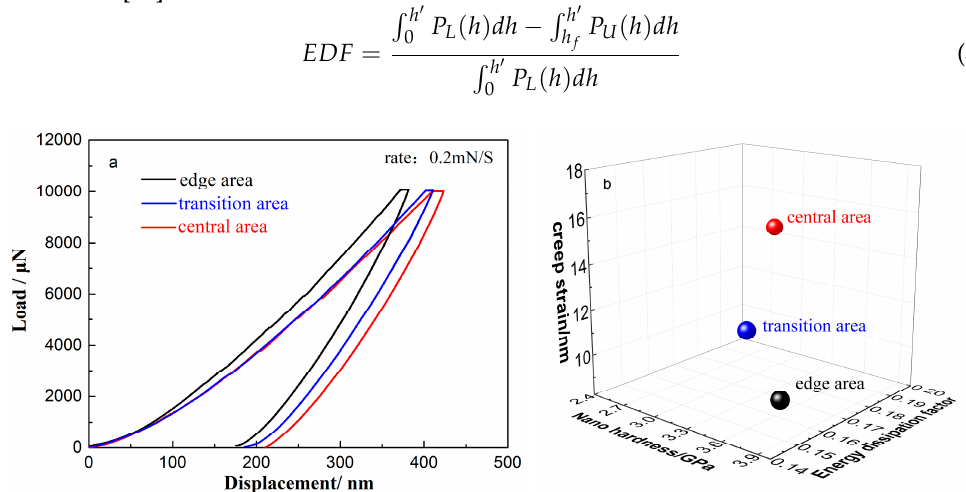
Figure 3. ( a ) P-H curves of nanofretting; ( b ) nano hardness, energy dissipation factor and creep strain in different areas.